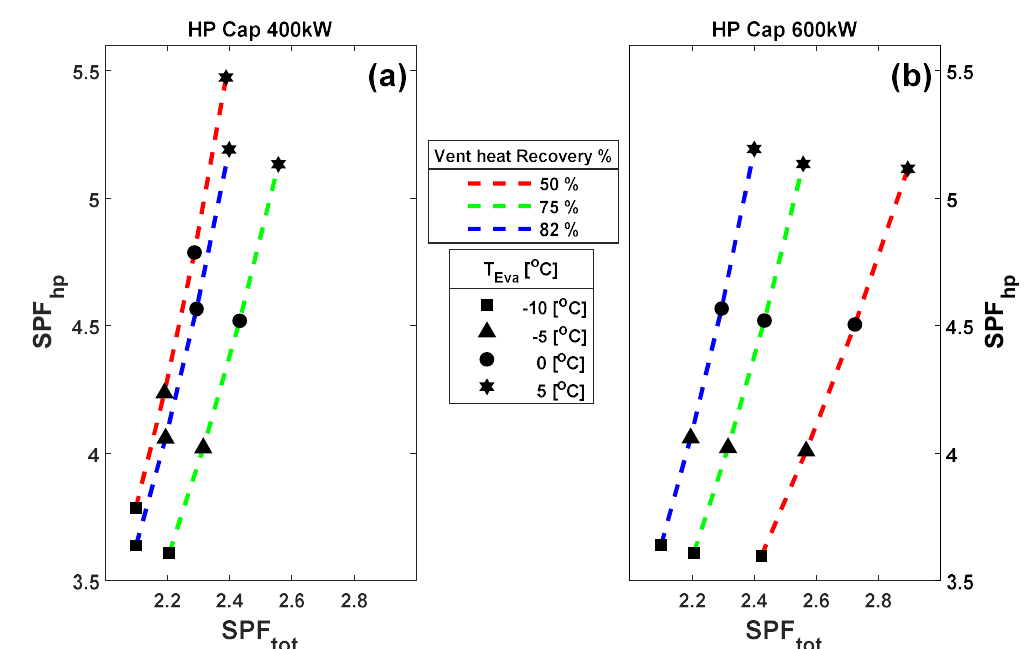
Figure 5. The influence of the evaporator temperature, ventilation heat recovery percentage, and the heat pump capacity: ( a ) 400 kW; ( b ) 600 kW on the heat pump and total SPF values for the ventilation temperature ratio of 70/30 °C/°C .